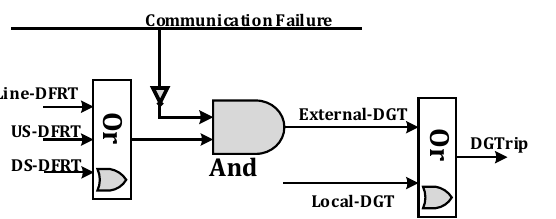
Figure 6. The proposed comprehensive DGU protection scheme configured by external and local trip commands.